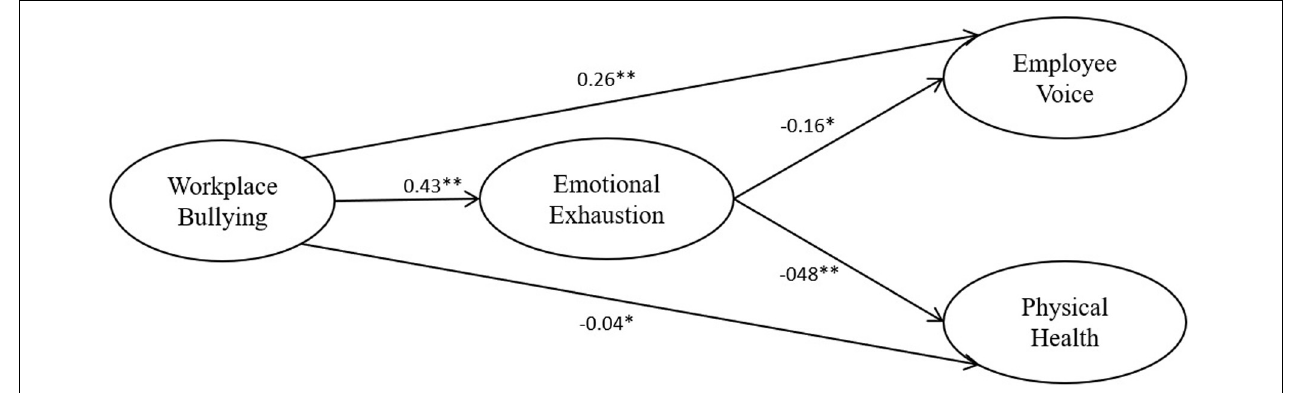
FIGURE 1 | Summary of results. Results are obtained from the structural equation modeling (SEM). * p < 0.05; ** p <